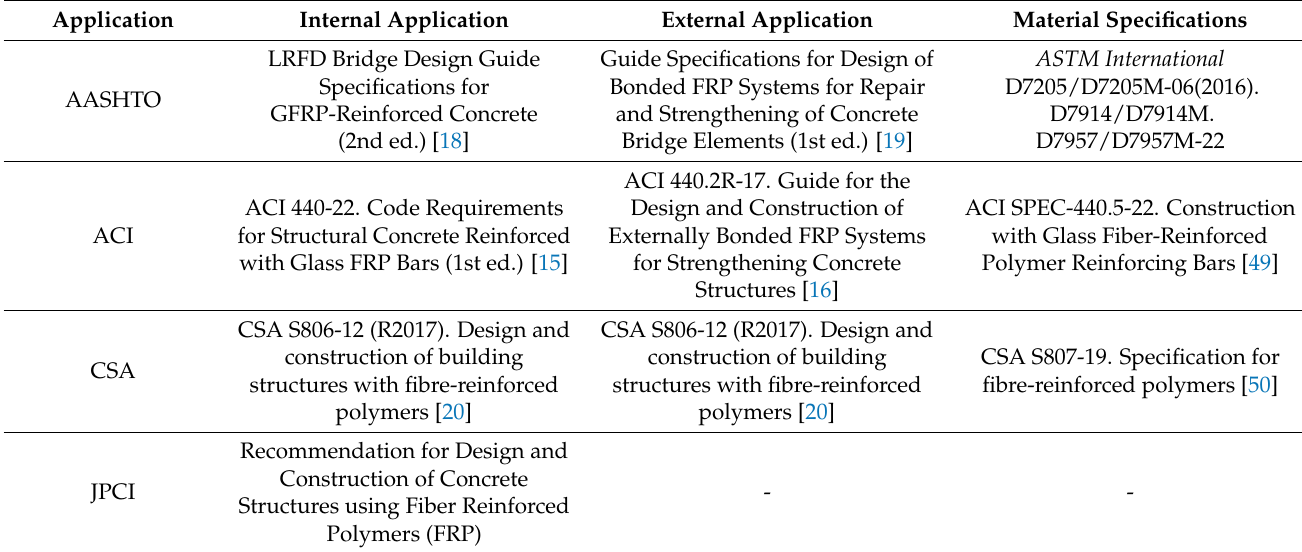
Table 1. Available design guides and codes focused on FRP